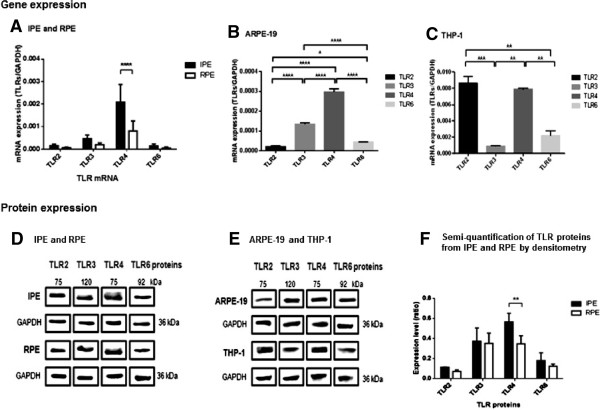
Expression of TLR2, −3, −4 and −6 mRNA and proteins in human IPE and RPE. Human IPE and RPE (A) from the same donor were cultured to confluence and expression of TLR2, −3, −4 and −6 mRNA and proteins was investigated by real-time PCR (A, B and C) and Western blotting (D, E and F) using specific primers and antibodies, respectively. The concentration of genes was measured using the comparative threshold cycle number and normalised to that of the GAPDH with ARPE-19 (B) and THP-1 (C) served as positive controls. Data represents mean ± SD (N = 3). Two-way ANOVA and Bonferroni’s multiple comparison test was used to analyse the data for A, **p < 0.01, ****p < 0.0001. One-way ANOVA and Turkey’s multiple comparison test was used to analyse the data for B and C, *p < 0.05, **p < 0.01, ***p < 0.001, ****p < 0.0001. Results are representative of three independent experiments (the results are consistent from three donors).